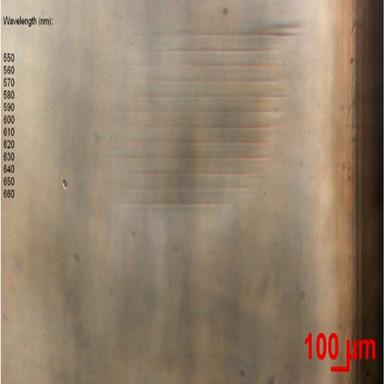
Filamentary modification of wavelength ranged from 550 nm–700 nm.